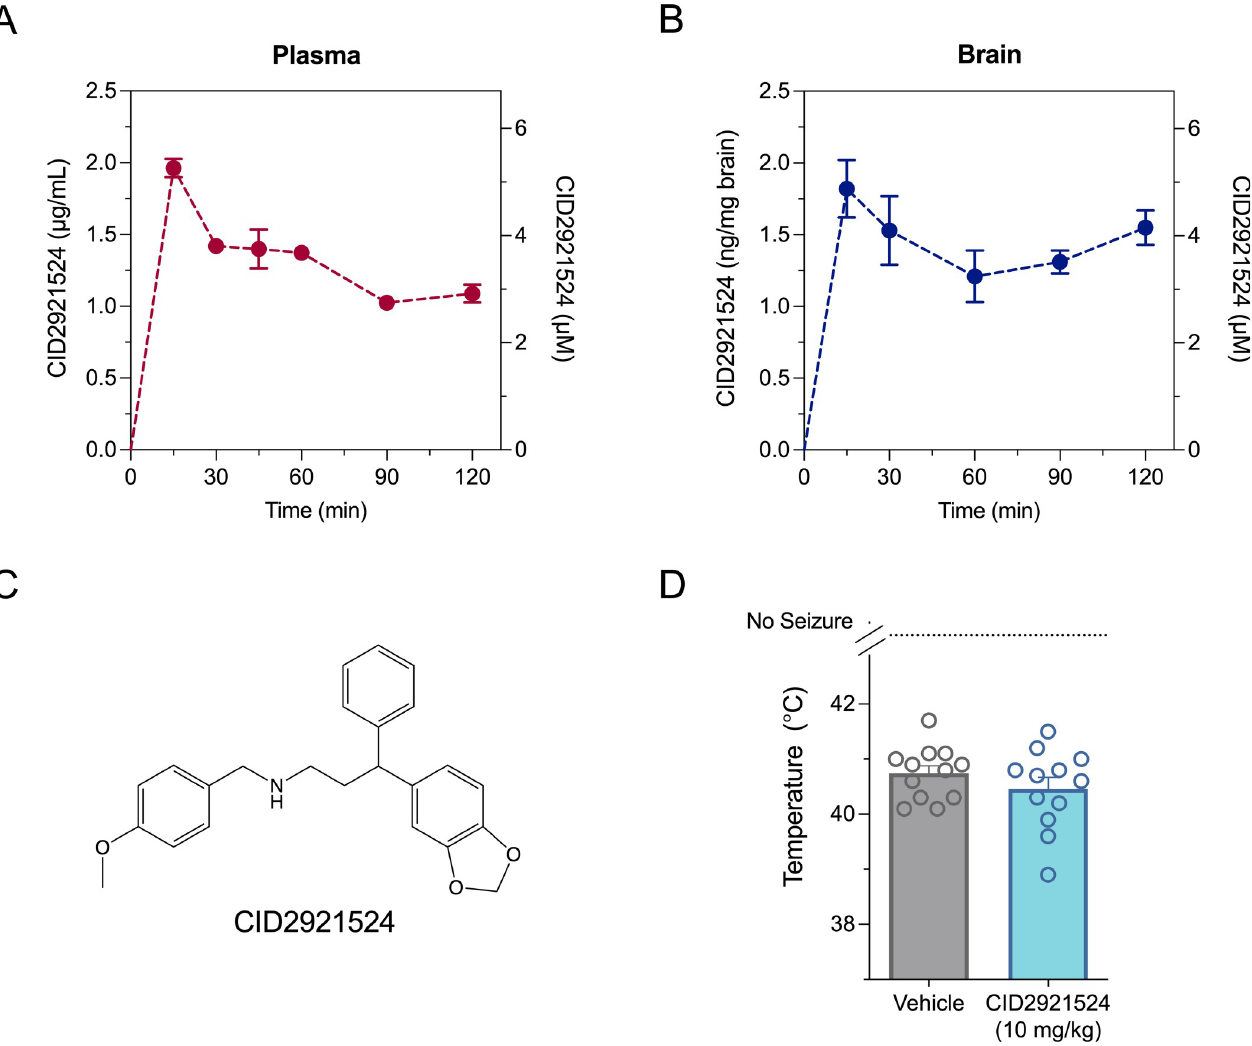
Fig 4. The GPR55 antagonist CID2921524 is brain penetrant but does not affect hyperthermia-induced seizures in Scn1a +/- mice. Concentration-time curves for CID2921524 in ( A ) plasma and ( B ) brain following a 10 mg/kg i.p. injection. Concentrations are depicted as both mass concentrations (left-axis) and molar concentrations (right y-axis). Data are expressed as means ± SEM, with n = 4 per time point. ( C ) Chemical structure of CID2921524. ( D ) Threshold temperature of individual mice for GTCS induced by hyperthermia in male and female F1. Scn1a +/- following acute treatment with vehicle (gray symbols) or 10 mg/kg CID2921524 (blue symbols). CID2921524 had no effect on a thermally induced seizure of F1. Scn1a +/- mice. The average temperatures of seizure induction are depicted by the bars and error bars represent SEM, with n = 12 (3 males and 9 females) per group (Mantel-Cox logrank).